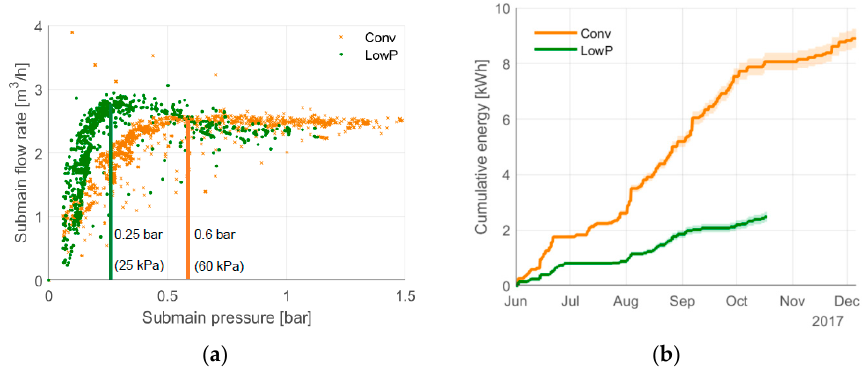
Figure 6. Sensor and calculated specific energy data for site 1 in Morocco. ( a ) Submain flow rate plotted against submain pressure, for pipes supplying both low-pressure ( LowP ) and conventional ( Conv ) emitter plots. All recorded data points are plotted, even for irrigation events with pressures below the MCIP, in order to demonstrate the full performance curve of the two emitters. The setpoint pressures for both submains are indicated with solid lines. ( b ) Cumulative hydraulic energy over the course of data recording. Only post-filtered data points are included in this plot. Vertical segments represent the increase in energy during an irrigation event; horizontal segments are data gaps or non-irrigated periods when flow rate and pressure are zero. The shaded areas represent the uncertainty due to flow and pressure sensor accuracy.